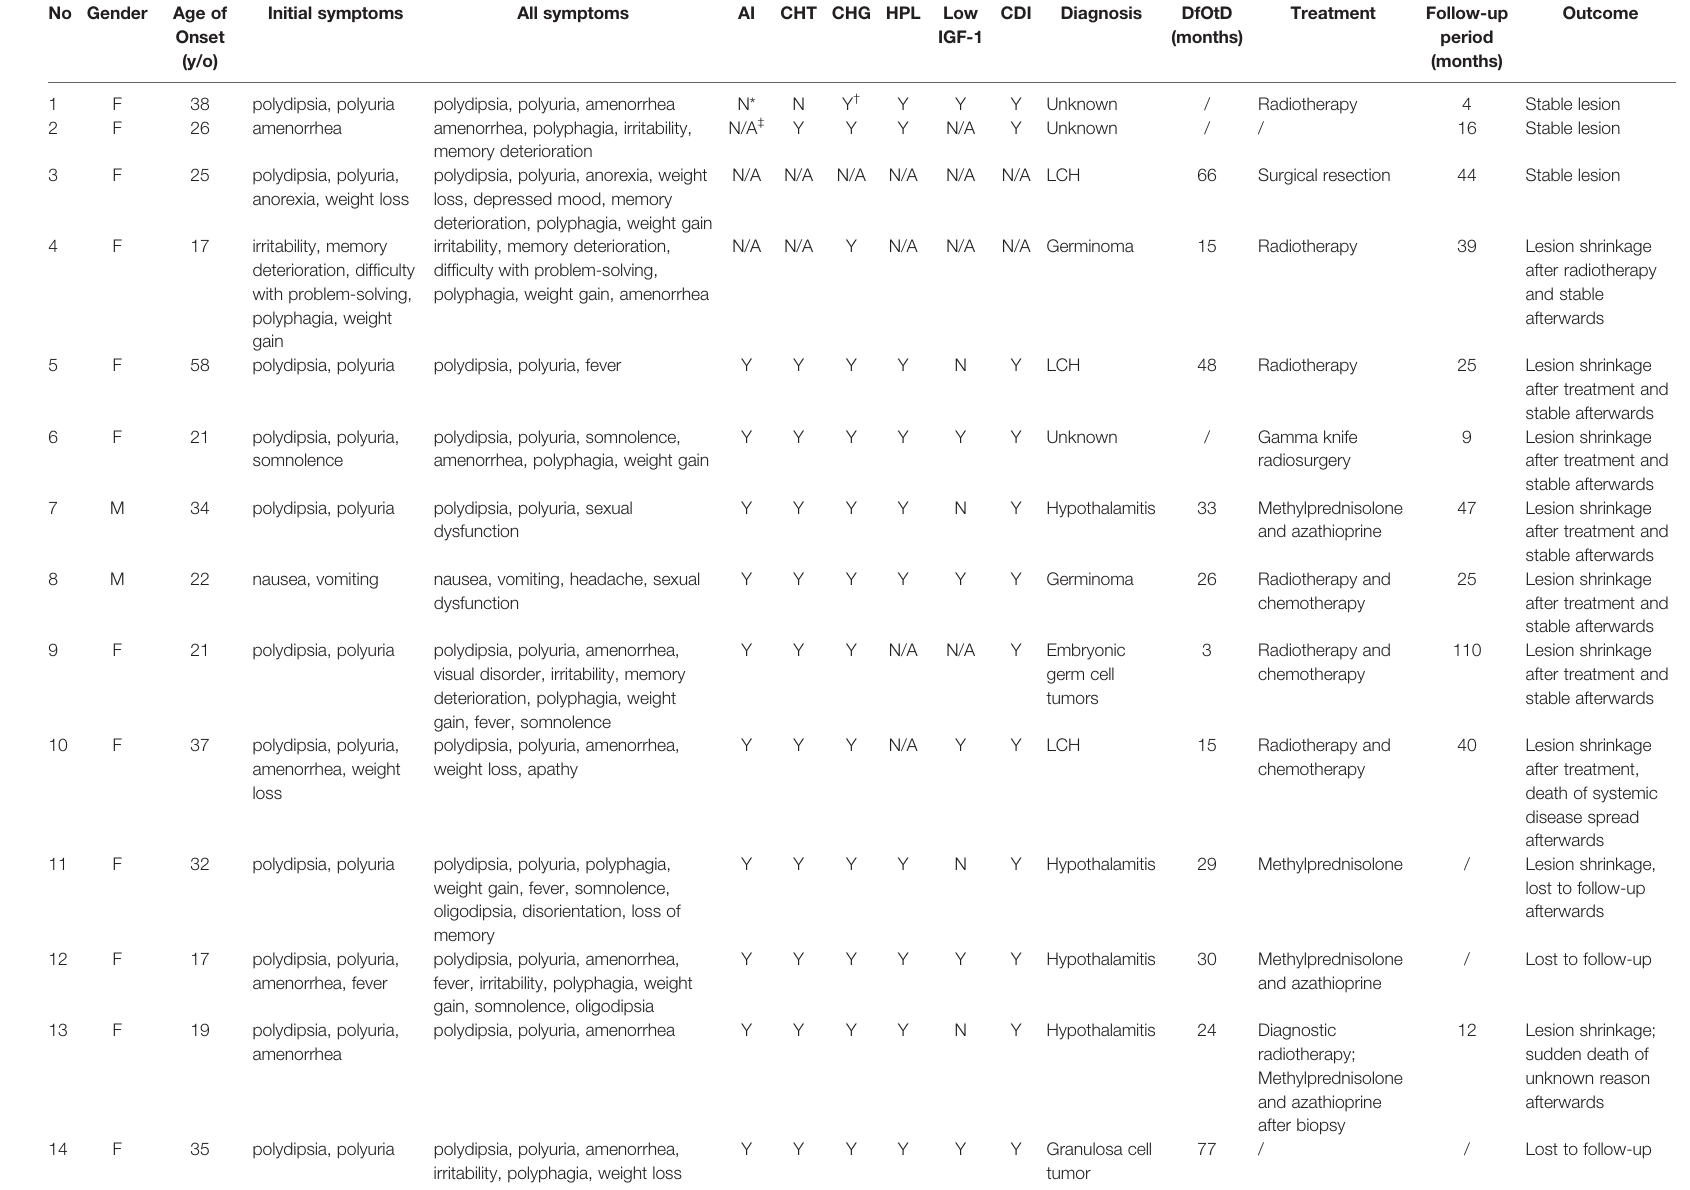
TABLE 1 | Short description of